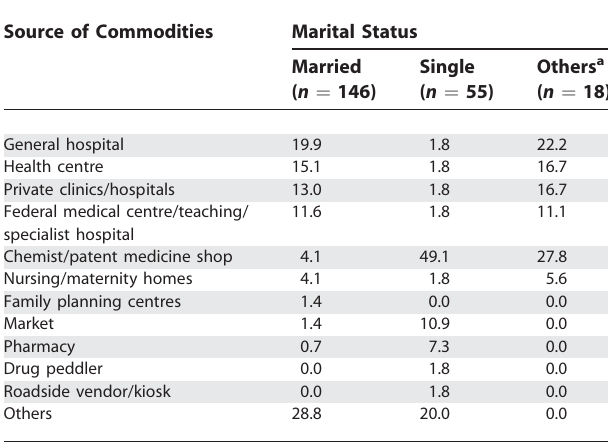
Table 6. Religion of Respondent and Source of Commodities by